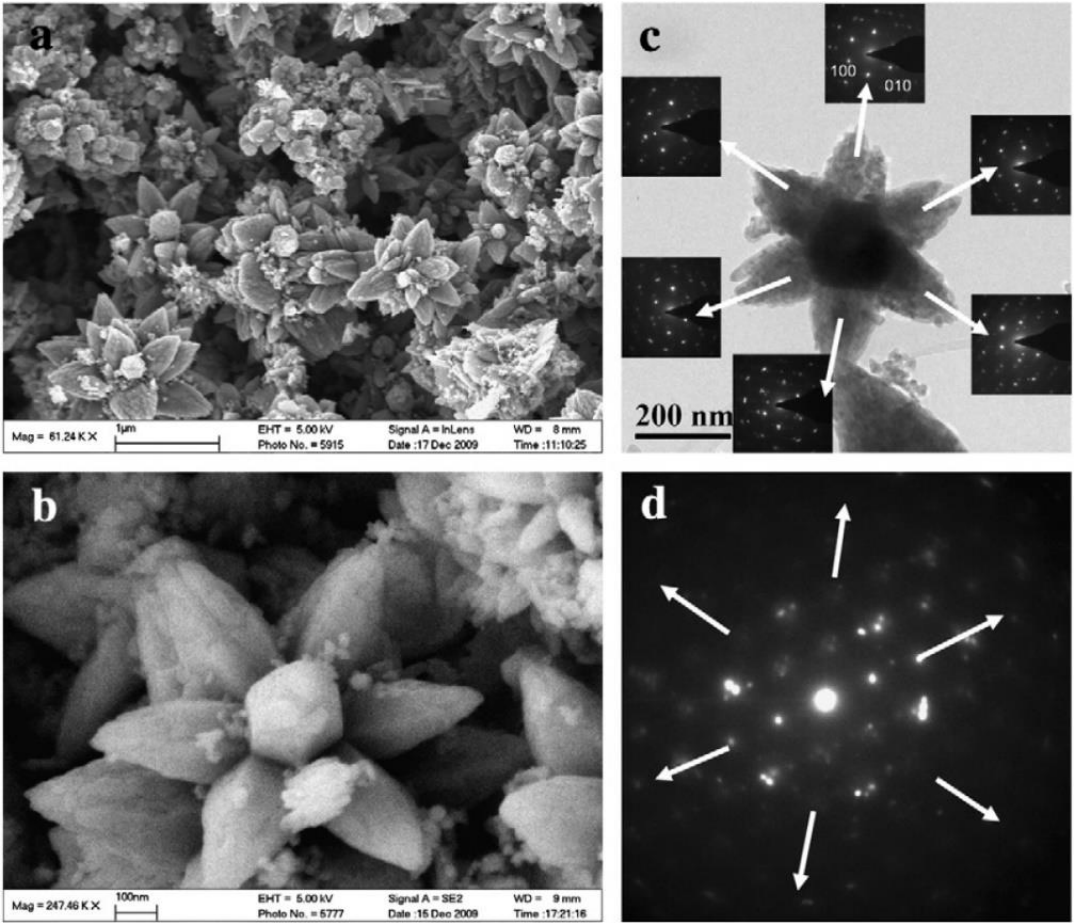
Figure 67. SEM images ( a , b ), TEM image ( c ) and SAED patterns ( d and insets of c ) of the flower-like ZnO nanostructures. Products synthesised by the microwave and ultrasonic wave combined method. Reprinted from [887], Copyright (2011), with permission from Elsevier [OR APPLICABLE SOCIETY COPYRIGHT OWNER]. All rights reserved. In order to re-use permission must be obtained from the rightsholder.